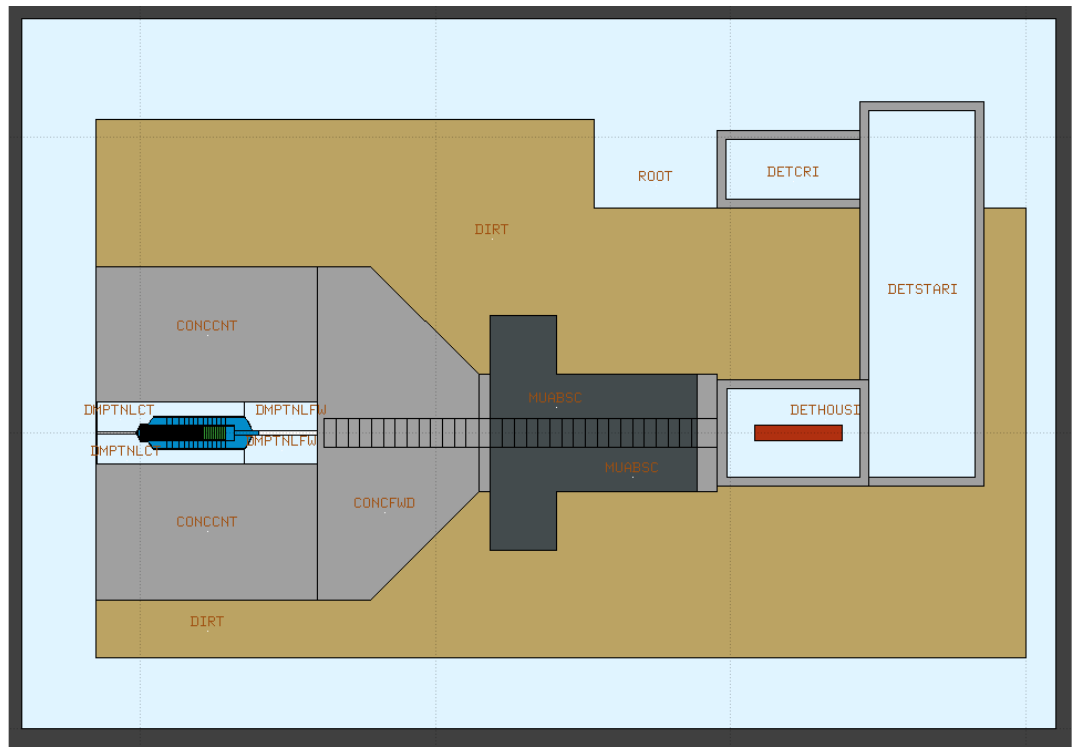
Figure 2. The BDX experimental setup, as implemented in FLUKA [15]. From left to right: the Hall-A beam dump (blue), the concrete (light-gray) and iron (dark-gray) shielding, and the BDX detector (red) located inside the new underground